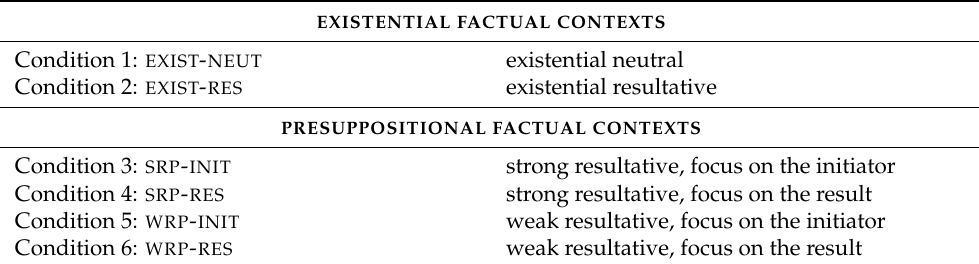
Table 1. The types of contexts tested in the